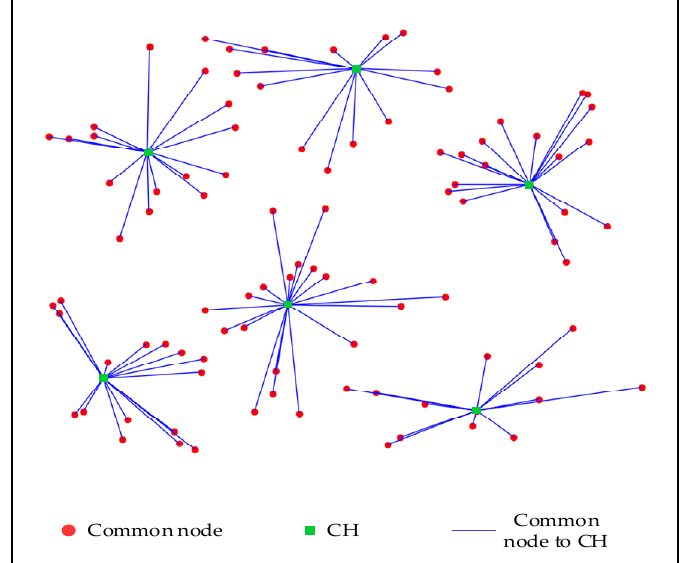
Figure 4. Cluster result of APSA (100 sensors).